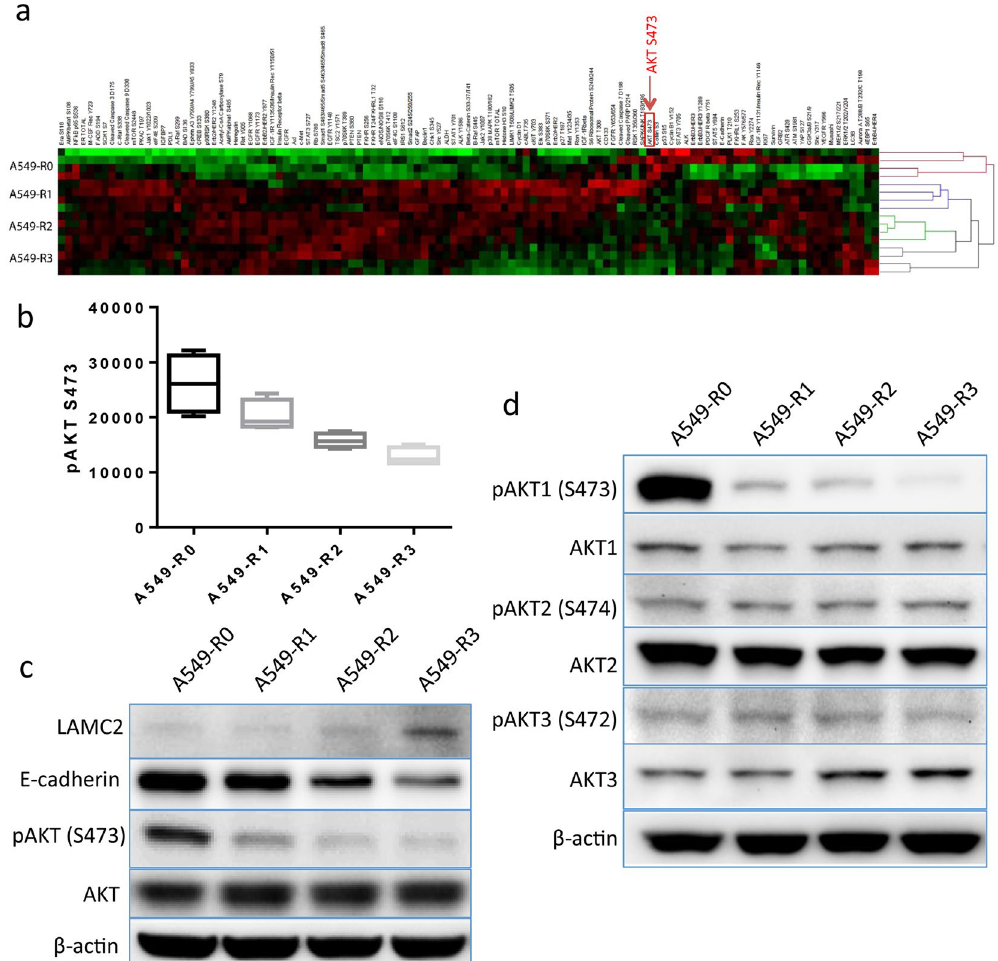
Figure 1. Inactivation of AKT1 signaling correlates with enhanced metastatic potential of A549 cells. ( a ) Heat map of RPPA data derived from A549-R0, -R1, -R2 and -R3 cells. Color scaling of relative protein levels: low (green), median (black) and high (red). ( b ) Signal intensities of S473-phosphorylated AKT quantified from the RPPA data of each subclone. Western blot analyses of ( c ) E-cadherin, pAKT (S473) and total AKT, and ( d ) phosphorylated- and total proteins of AKT1, 2, and 3 in the A549 subclones. ß-actin was used as loading